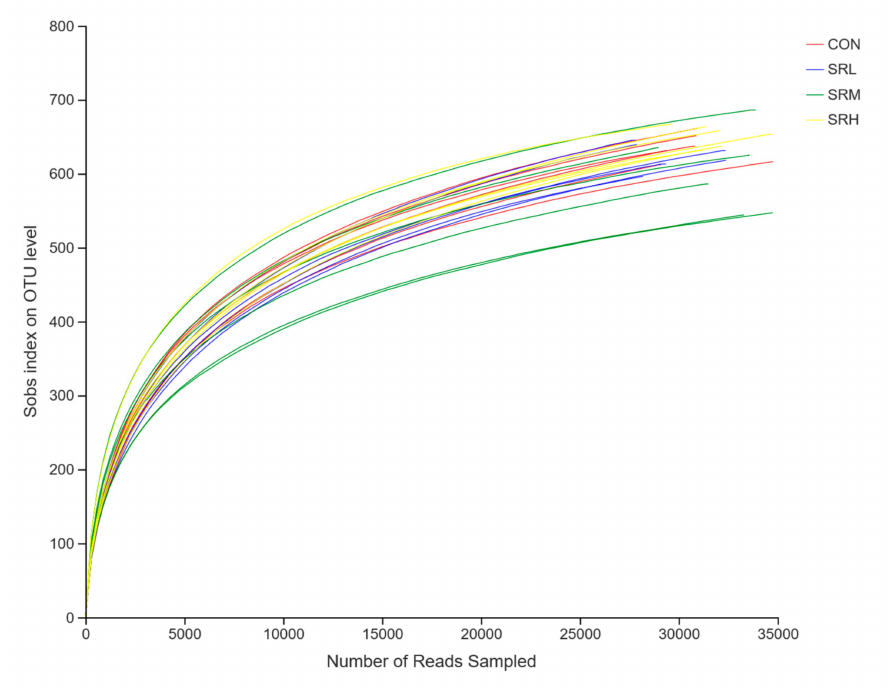
Figure 3. Sobs index exponential dilution